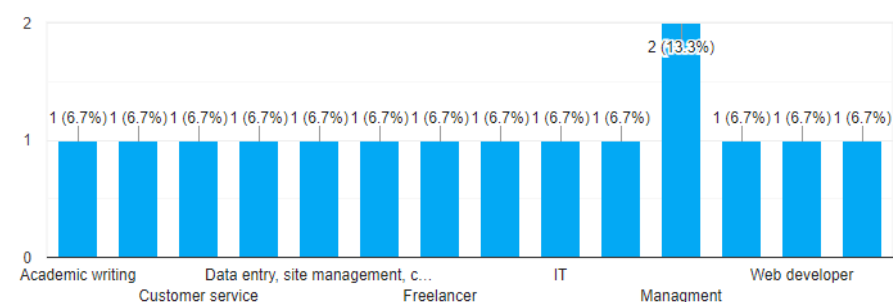
Figure A3. A survey report showing responders skills.